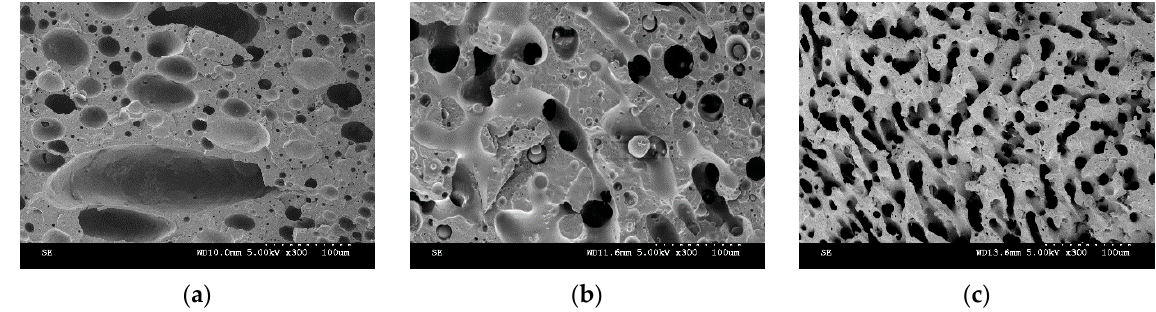
Figure 3. Morphology evolution of selected PP/PS/MWCNTs composites after fast-cooling treatment for: ( a ) 0 wt.% of MWCNTs; ( b ) 0.1 wt.% of MWCNTs; and ( c ) 0.5 wt.% of MWCNTs.